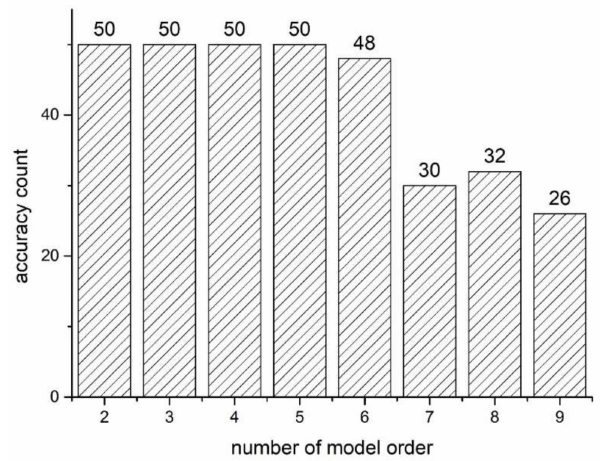
Figure 12. The accuracy performance for different numbers of model